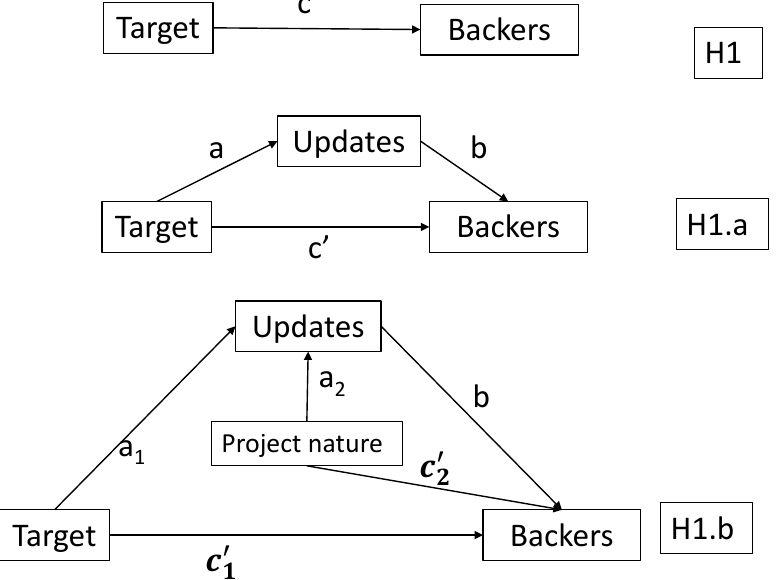
Figure 1. Basic, mediated and moderated mediation models of Target and Updates on Backers